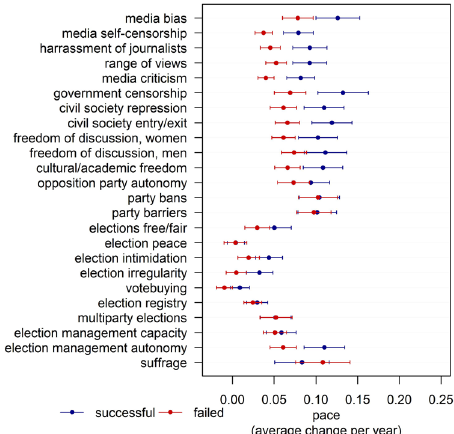
Fig. 4 Rate of change for 24 democracy indicators during successful and failed liberalization episodes. On average across the length of the episode, the rate of change was signi fi cantly higher ( t -test p < 0.05) for successful episodes for eight measures of freedom of expression (academic freedom, freedom of discussion for women, government censorship, media criticism, harassment of journalists, media self- censorship, range of views, and media bias), two measures of freedom of association (entry and exit of organizations and civil society repression), and election management body